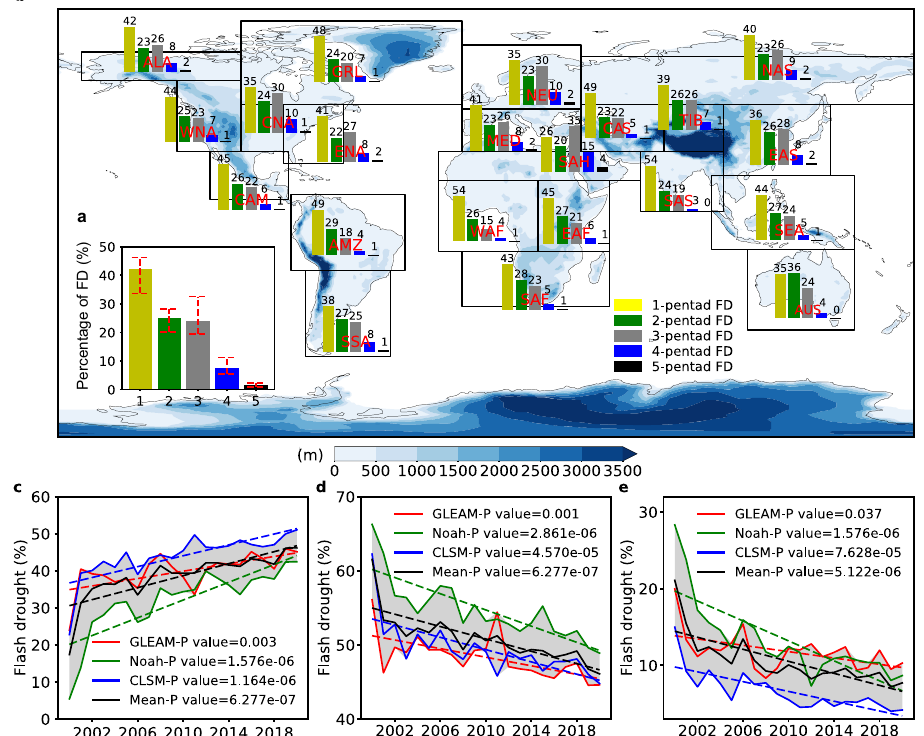
Fig. 2 Comparison of percentages of fl ash droughts at different onset times relative to all fl ash droughts and their temporal evolutions. a Global proportion of fl ash droughts at different onset times relative to all fl ash droughts. The red dashed lines at the top of each bar represent the range of uncertainty in three different datasets. b Proportion of fl ash droughts at different onset times relative to all fl ash droughts over 21 regions. c – e Temporal evolutions of percentages of fl ash droughts with the onset times of 1-, 2-3, and 4-5 pentads relative to all fl ash droughts. The linear annual trends in the proportion of fl ash droughts at different onset times are estimated based on the Sen ’ s slope estimator, and statistical signi fi cances in trends are determined based on the MK test for the entire study period (2000 − 2020). The shaded areas represent the range of uncertainty in three different